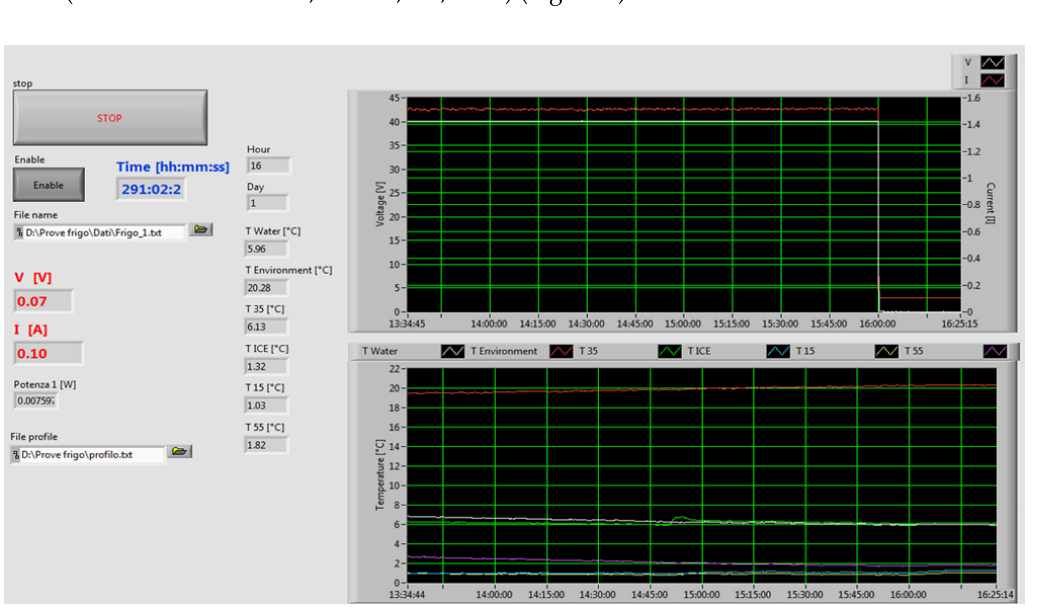
Figure 4. Front panel of the developed virtual instrument (VI).